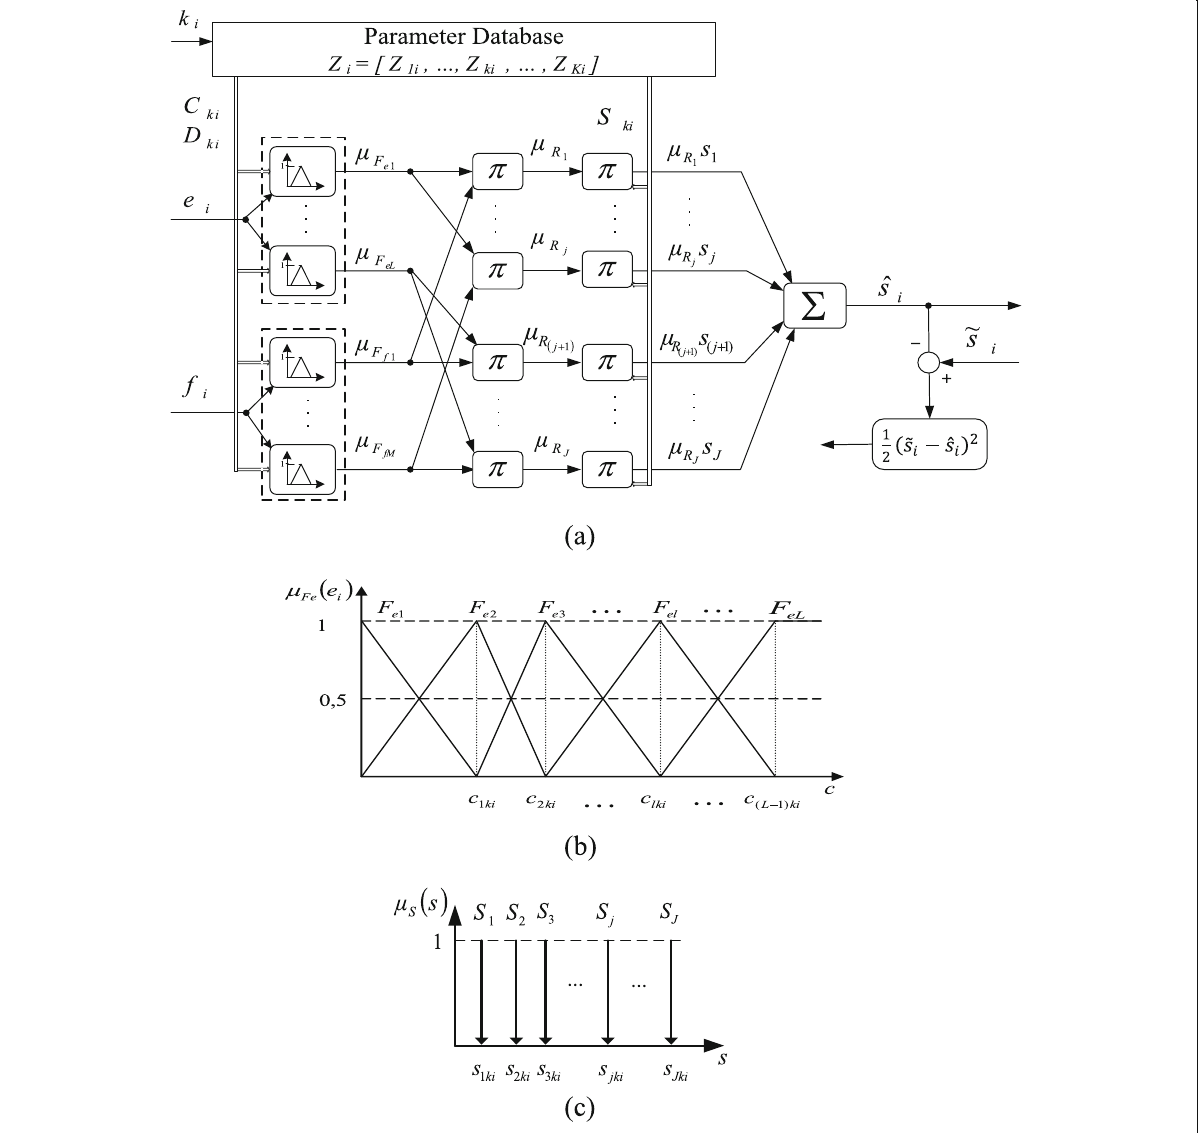
Fig. 5 Neuro-fuzzy model: ( a ) overall view, ( b ) input fuzzy sets functions, ( c ) output fuzzy sets